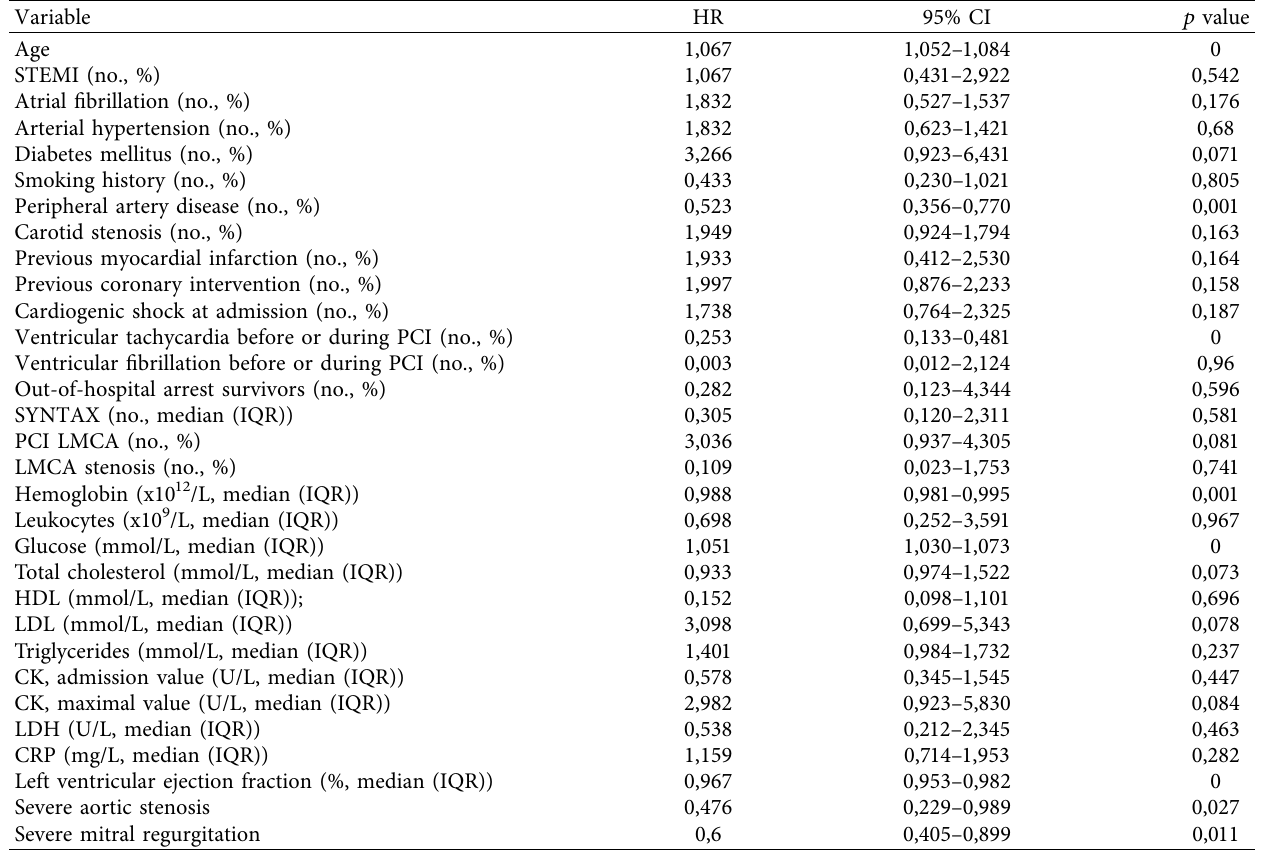
Table 2: Multivariant